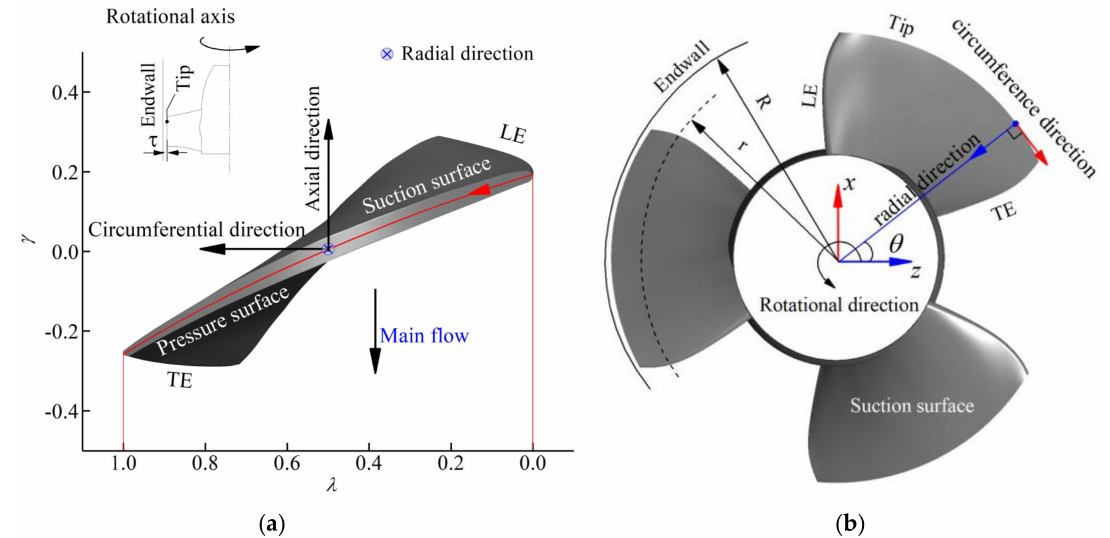
Figure 6. Geometric definition of the impeller. ( a ) Chord length coefficient λ and axial coefficient γ ; ( b ) Radial coefficient r*.